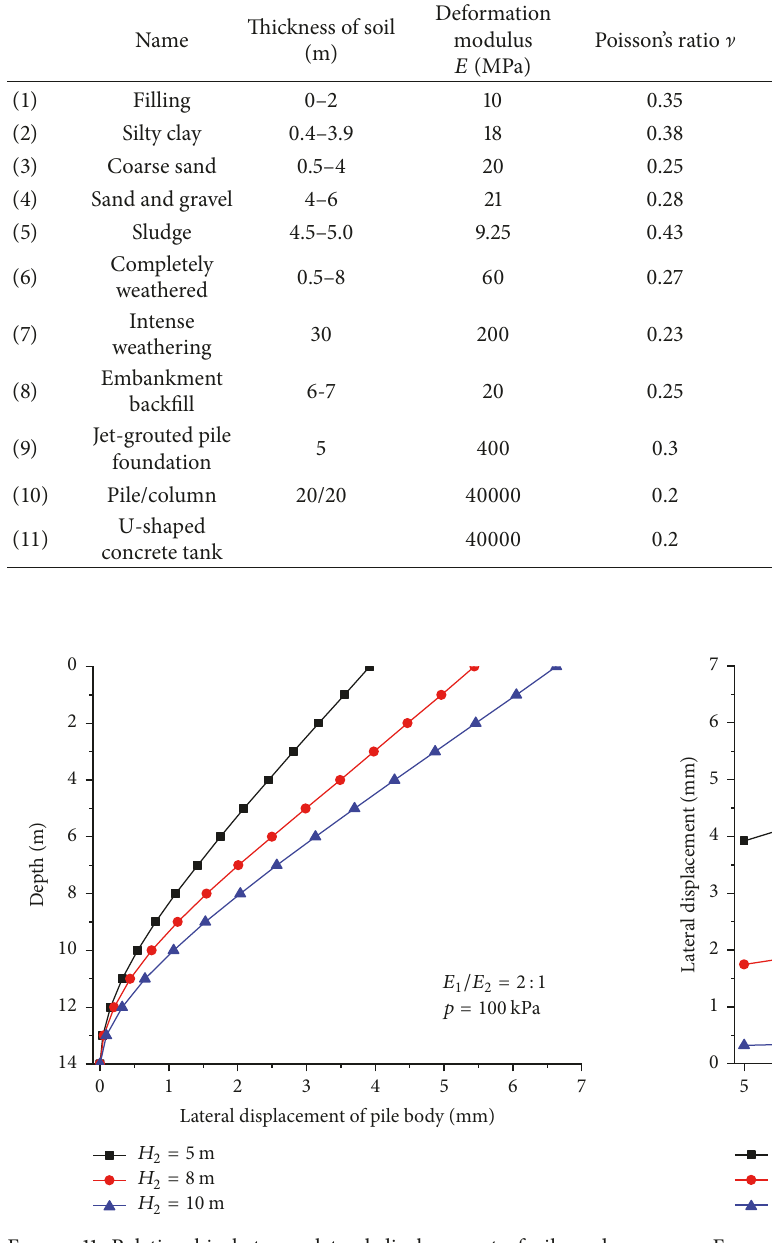
Figure 12: Lateral displacement at different